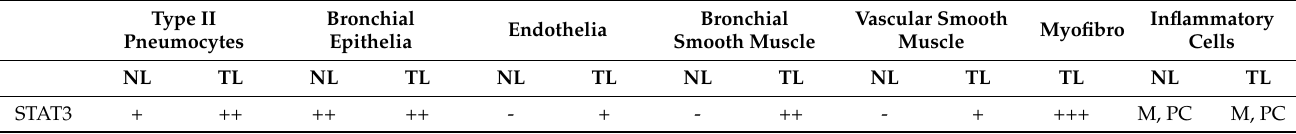
Table 3. Topographic and semi quantitative evaluation of